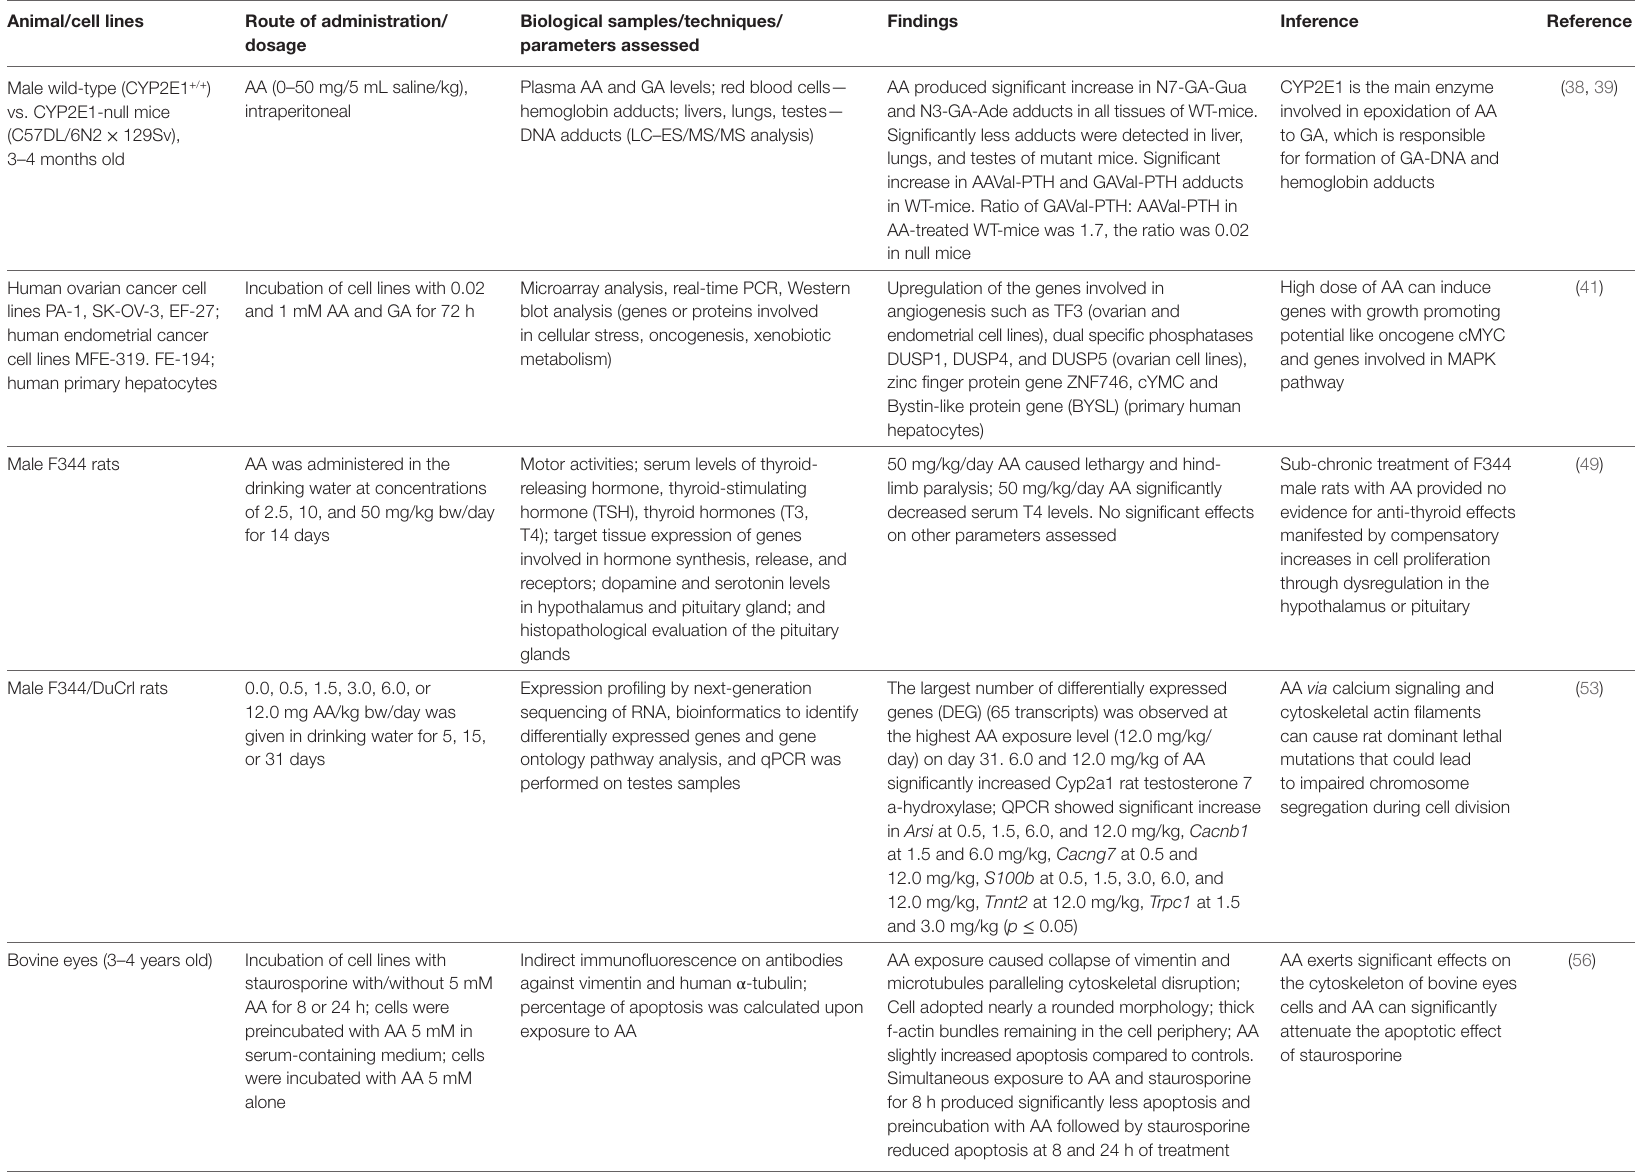
TABLe 1 | Acrylamide (AA) exposure-induced toxicity. Animal/cell